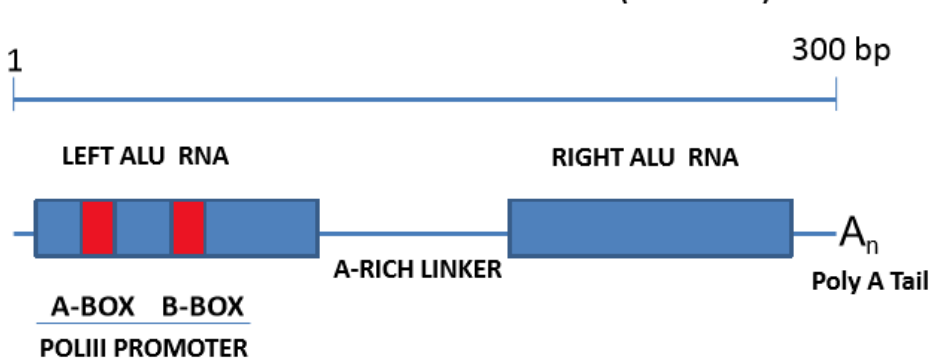
Figure 1. Structural features of Alu repeated sequences. Shown here are the distinctive elements forming an Alu monomer. The two arms are linked by an A-rich sequence (the bipartite A,B boxes), capped by an RNA polymerase III (Pol III) promoter and a poly-A tail. Graphic not drawn to